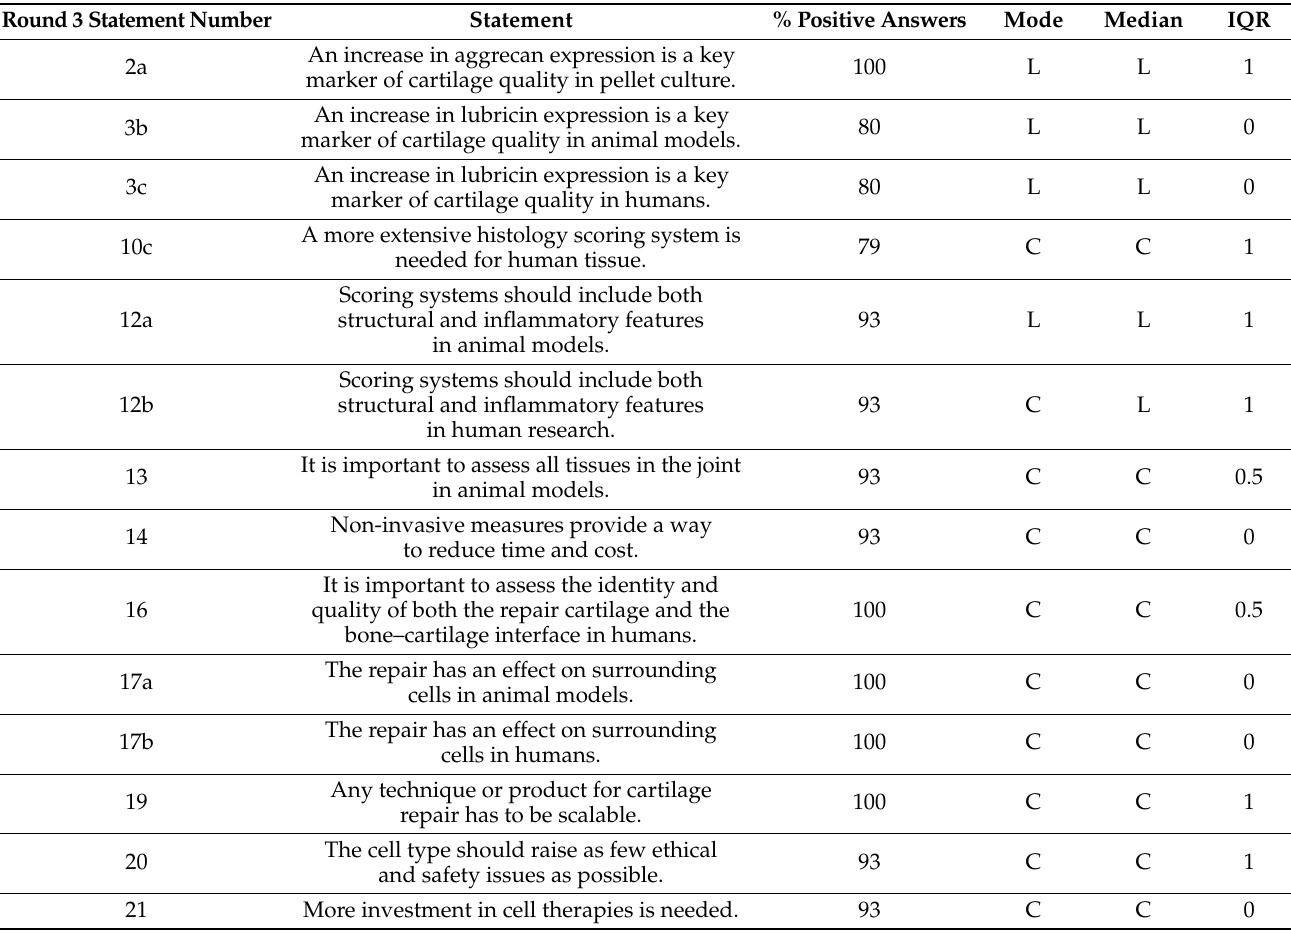
Table 3. A summary of the Likert-scale-rated single statements that reached consensus in round 3 (APMO 66.67%, IQR ≤ 1). Round 3 Statement